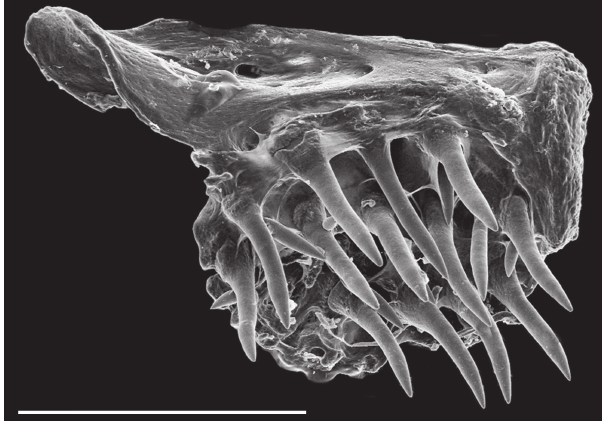
Fig. 3. Scanning electron micrograph. Ventral view of left premaxilla, showing the dentition pattern of Eigenmannia sayona (MZUSP 119711, paratype, 116.2 mm LEA). Scale bar: 0.5